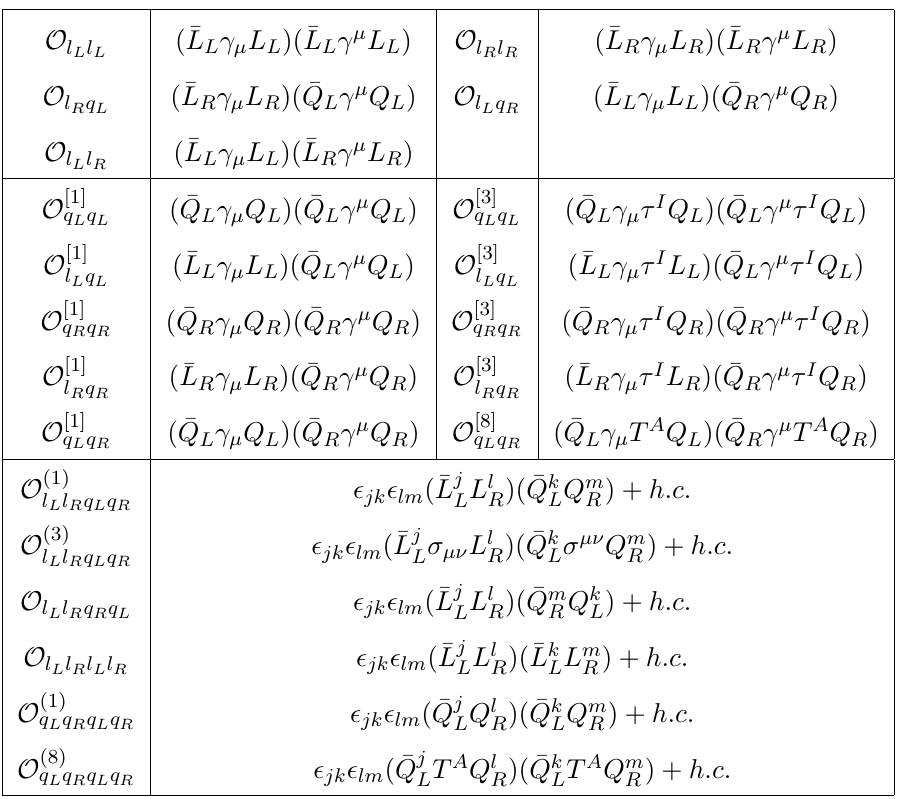
2 = 27] class of operators. (cid:2)